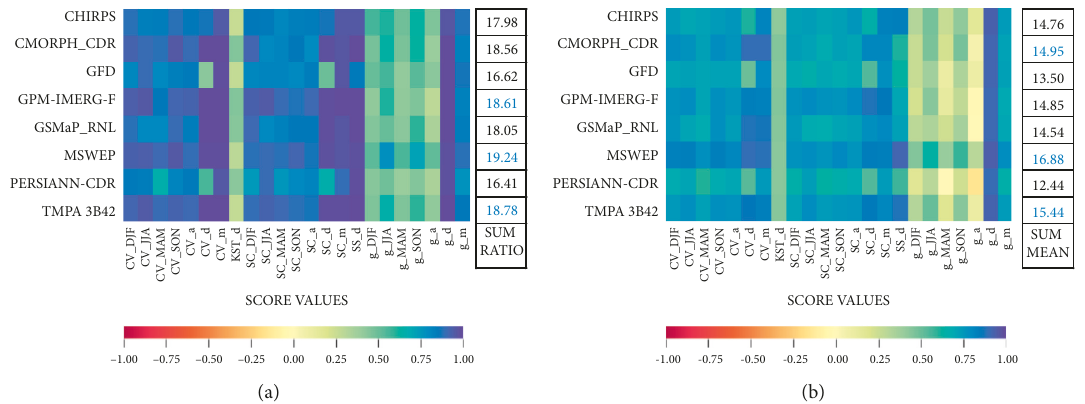
Figure 2: Heatmaps of distribution performance metrics by ratio (a) and mean (b) with corresponding